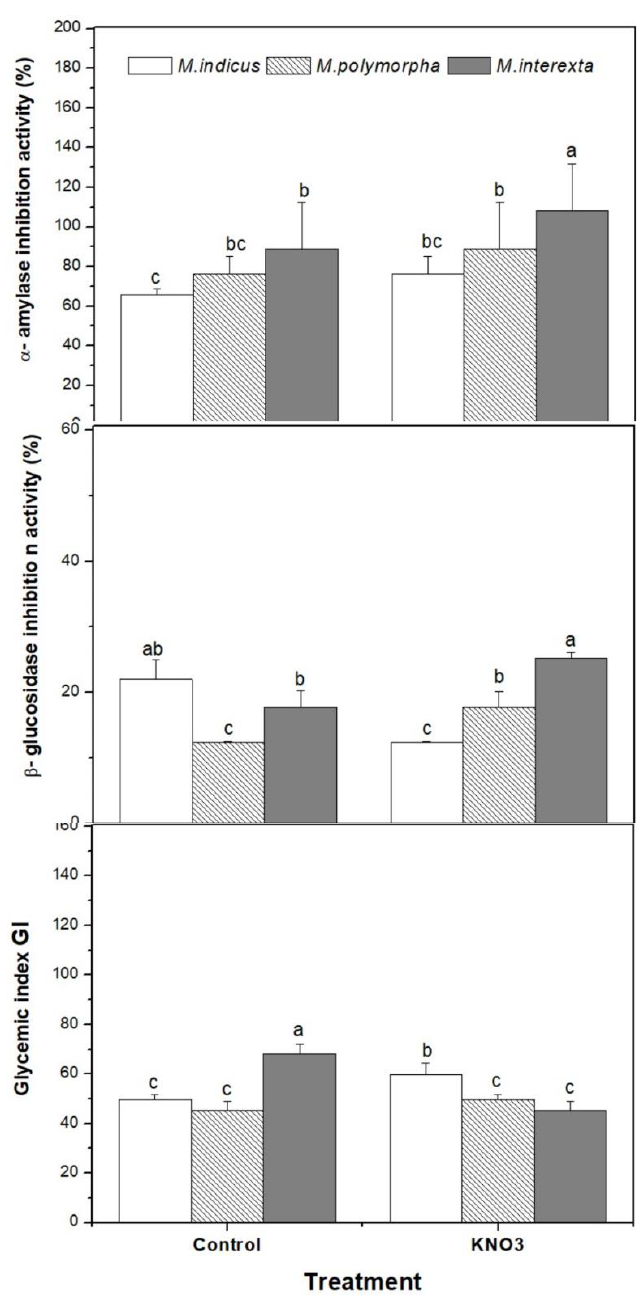
Figure 4. Effect of KNO 3 priming on antidiabetic activity of three species of Medicago sprouts. Values are represented by mean ± standard deviation of at least three independent replicates. Within the same species, different letters on the bars indicate significant differences at p < 0.05.